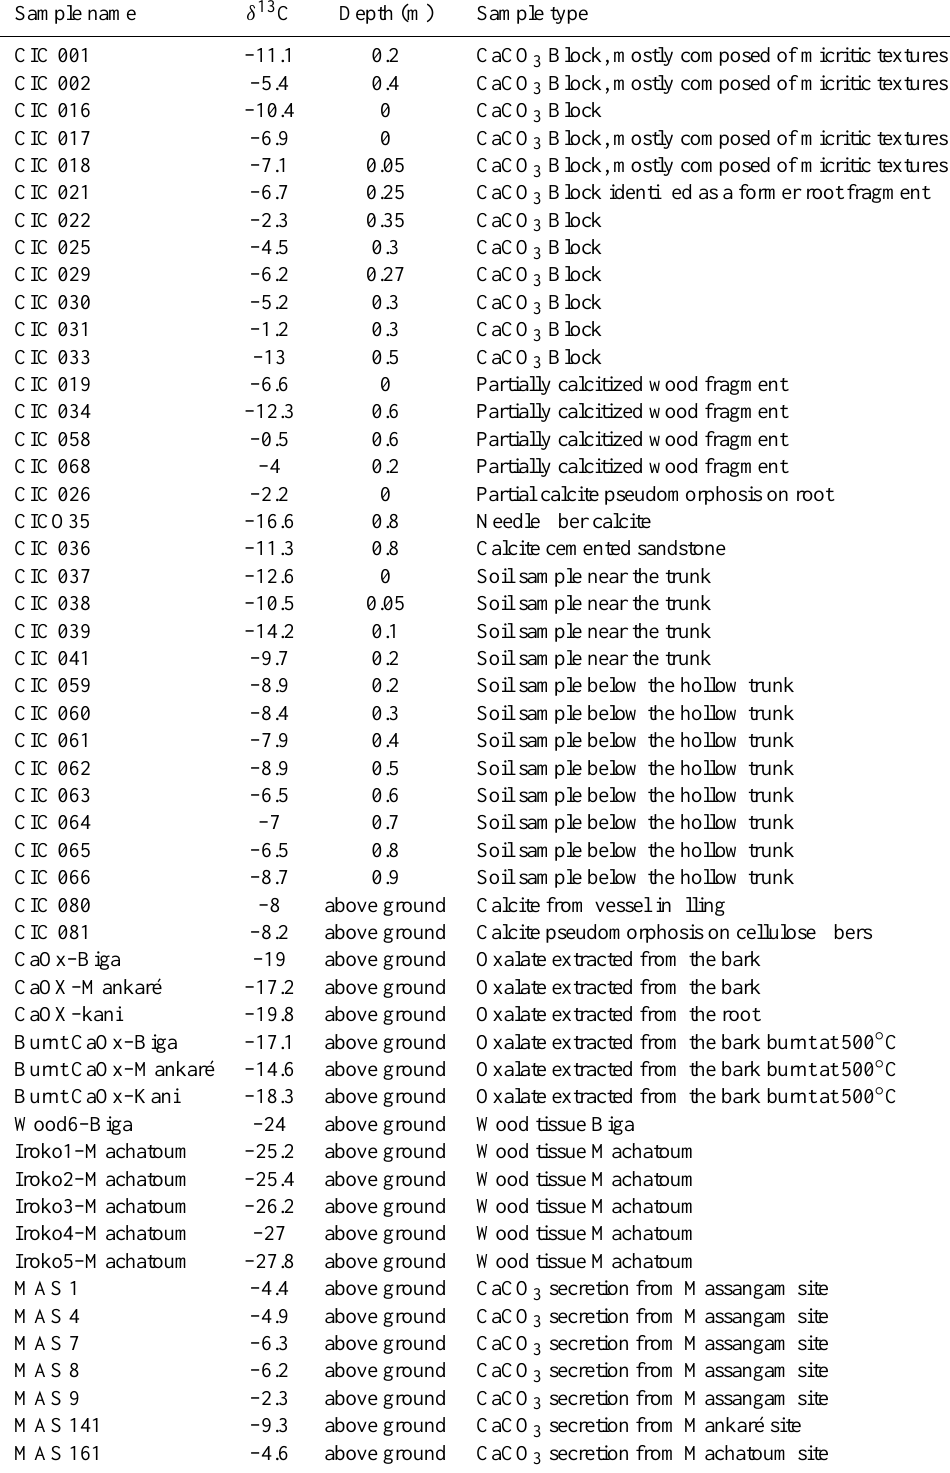
Table 1. C isotope signatures from both carbonate and organic matter (Ivory Coast and Cameroon samples). CIC sample names refer to Biga site